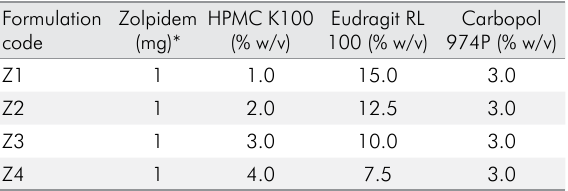
Table 1. Composition of different polymeric buccal films containing zolpidem nanospheres